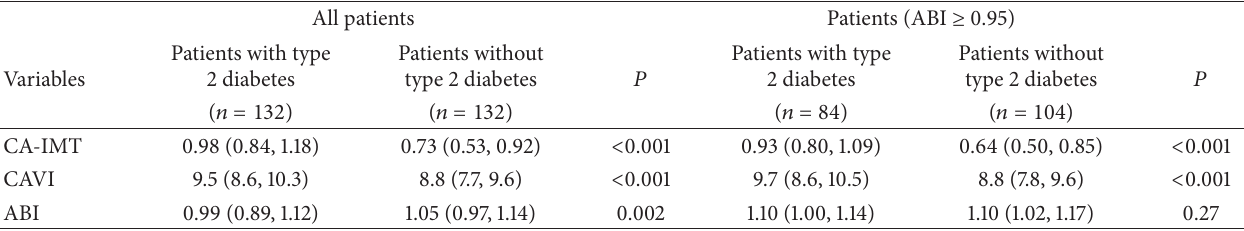
Table 2: Comparison of arteriosclerosis markers between hemodialysis patients with or without type 2 diabetes according to ABI levels. All patients